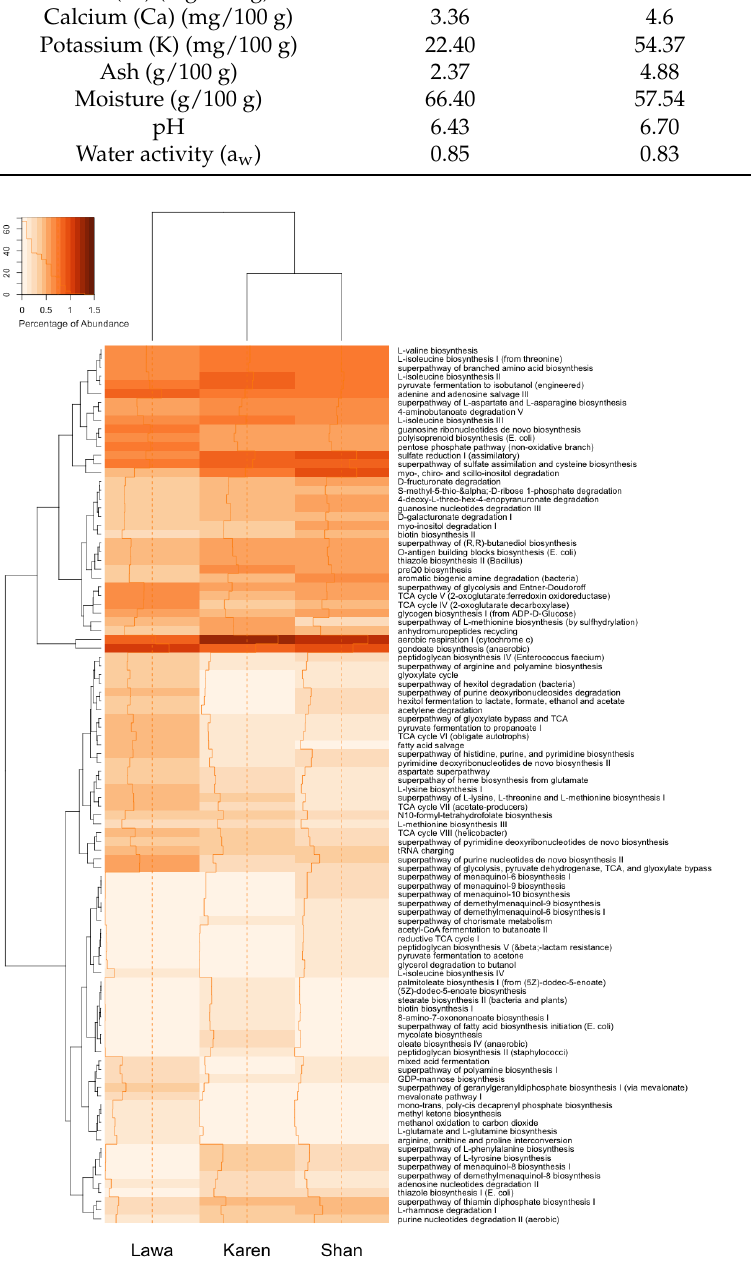
Figure 6. Top 100 functional genes predicted from the bacterial communities in the FSBs from the three ethnic groups, Lawa, Karen, and Shan.